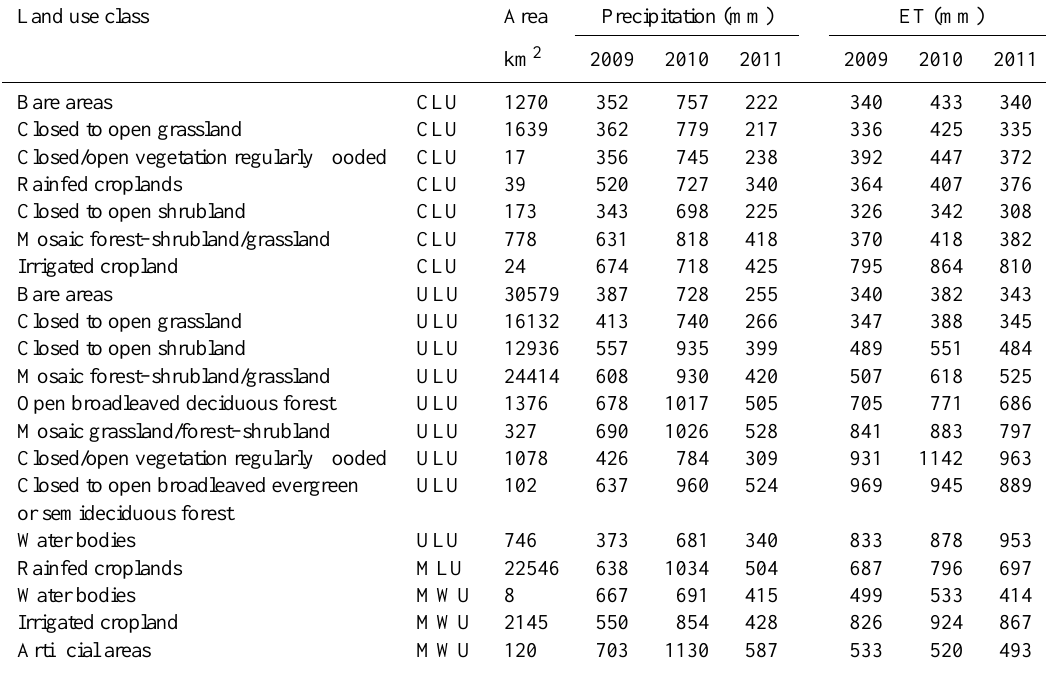
Table 7. Rainfall and ET by land use class for 2009, 2010 and 2011. CLU is conserved land use, ULU is utilized land use, MLU is modified land use, and MWU is managed water